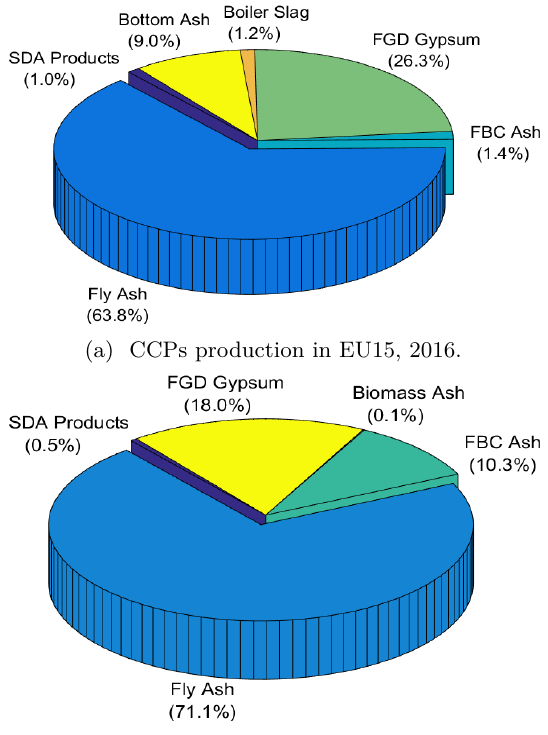
Figure 1. Statistics of CCPs production. (note: SDA - Semi Dry Absorption, FGD - Flue Gas Desulphurization, FBC - Fluidized Bed Combustion)